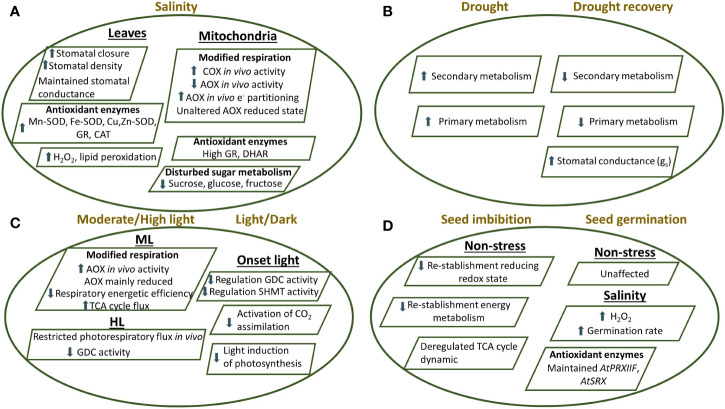
Proposed model showing the response of Arabidopsis thaliana plants knockout of the mitochondrial TRXo1 under different stress conditions as (A) salinity in leaves and mitochondria, (B) drought and drought recovery, (C) moderate light/high light and (D) during seed imbibition and germination, as detailed in the main text (Daloso et al., 2015; Ortiz-Espín et al., 2017; Calderón et al., 2018b; Florez-Sarasa et al., 2019; Sánchez-Guerrero et al., 2019; Da Fonseca-Pereira et al., 2019b; Da Fonseca-Pereira et al., 2019c). Effect on stomatal behaviour, antioxidant and oxidative metabolism, respiration and photorespiration, photosynthesis, TCA cycle as well as primary and secondary metabolism are shown in the KO plants compared to non-transformed plants. AOX, alternative oxidase; CAT, catalase; COX, cytochrome oxidase; Cu/Zn-SOD, copper-zinc superoxide dismutase; DHAR, dehydroascorbate reductase; GDC, glycine decarboxylase; Fe-SOD, iron superoxide dismutase; GR, glutathione reductase; Mn-SOD, manganese superoxide dismutase; PRXIIF, peroxiredoxin IIF; SHMT, serine hydroxymethyl transferase; SRX, sulfiredoxin; TCA, tricarboxylic acid.